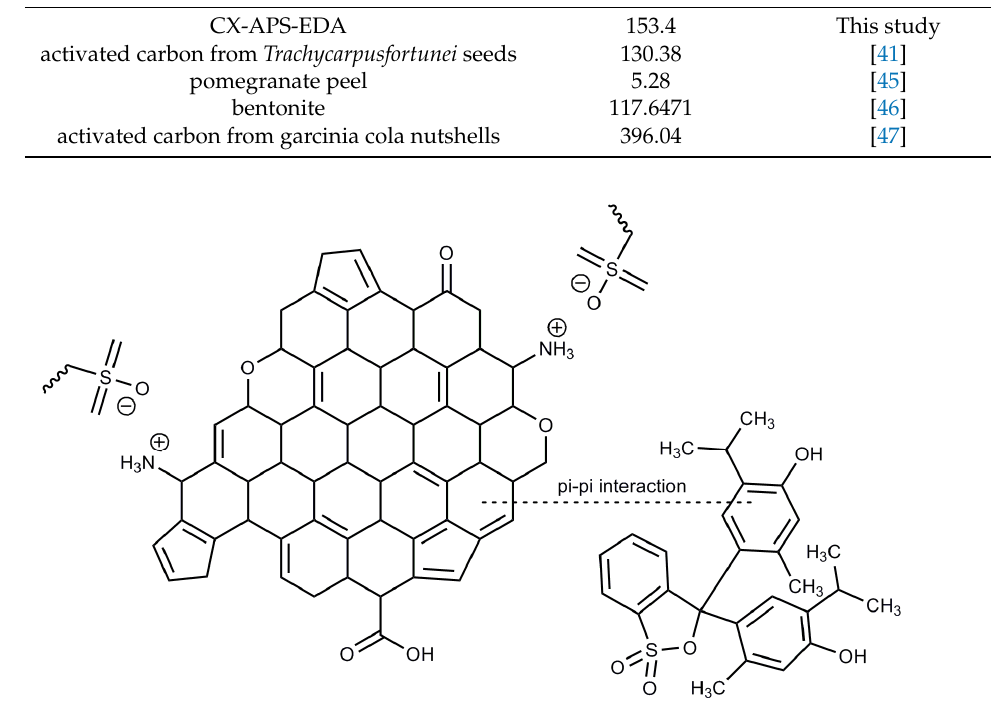
Figure 9. The proposed mechanism of the adsorption of thymol blue onto modified carbon xerogels.